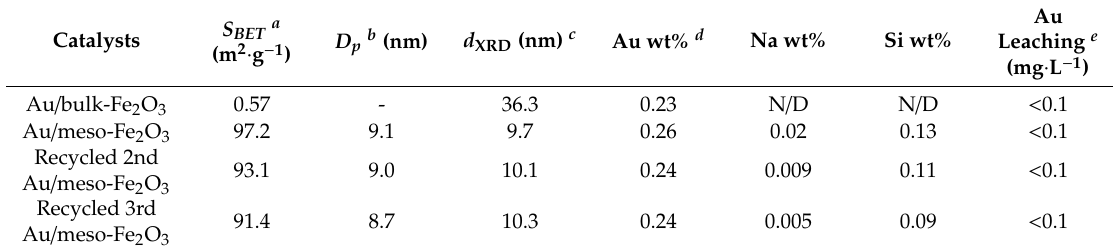
Table 1. The structural and chemical properties of Au / meso-Fe 2 O 3 and selected iron-based catalysts.